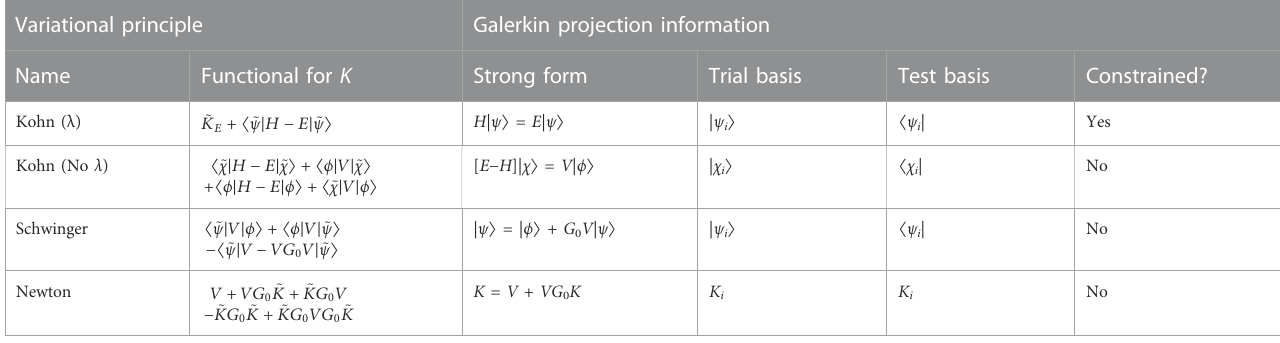
TABLE 1 Description of common variational principles (VPs) in quantum scattering, and how to relate them to a Galerkin projection. The quantities are de fi ned as the free wave function| ϕ 〉 ,thefullwavefunction| ψ 〉 ,thescatteredwavefunction| χ 〉 ,andthereactancematrix K alongwithitson-shellform K E .Tildesdenotetrialquantities.Theexpressionsfor the Newton VP are written in operator rather than scalar form; any matrix element can be made individually stationary (see Section 4.4 for details). To compute the weak form of the Schwinger and Newton VPs, one must fi rst left multiply by V ( θ ) and G 0 , respectively, before orthogonalizing against the test basis. The rightmost column speci fi es whether a constraint for the trial wave function has to be imposed ( e . g ., using a Lagrange multiplier λ ). Variational